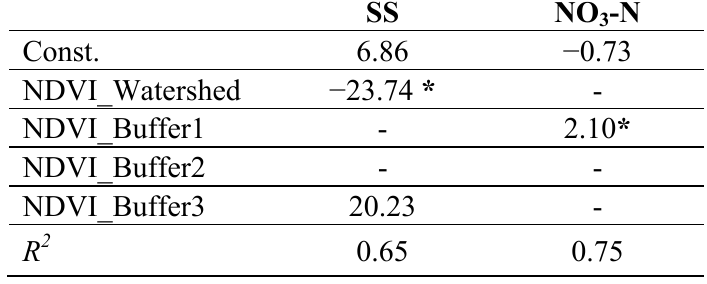
Table 4. Regression model for the function of water quality and average NDVI in various